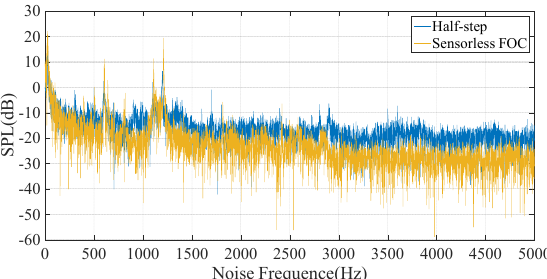
Figure 14. Testing result: the SPL spectrum of the motor at 120 rpm loaded operation.